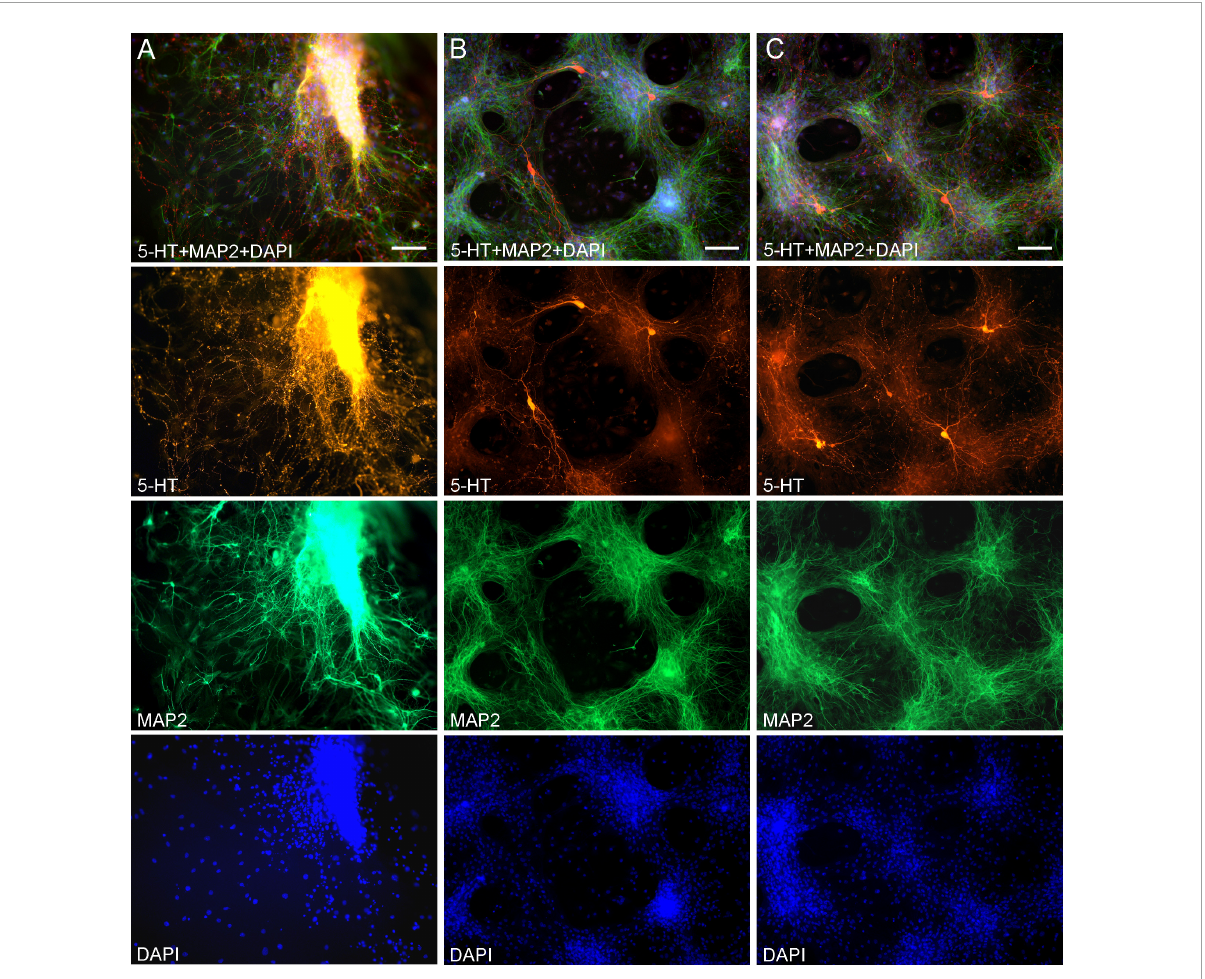
FIGURE1 Primary midbrain cultures (all monolayers at DIV 5), visualized with immunocytochemistry for 5-HT (red) and MAP2 (green) and imaged with epifluorescence microscopy. Cell nuclei are stained blue (DAPI). (A) A tissue piece from the midbrain raphe region, the cells of which have not been fully dissociated. Long serotonergic axons with varicosities emerge from the tissue, suggesting that the culture protocol can also be used in organotypic preparations. (B,C) Typical dissociated serotonergic neurons, with morphological features (round or fusiform somata) and neurites virtually indistinguishable from those in intact neural tissue. Scale bar = 100 µ